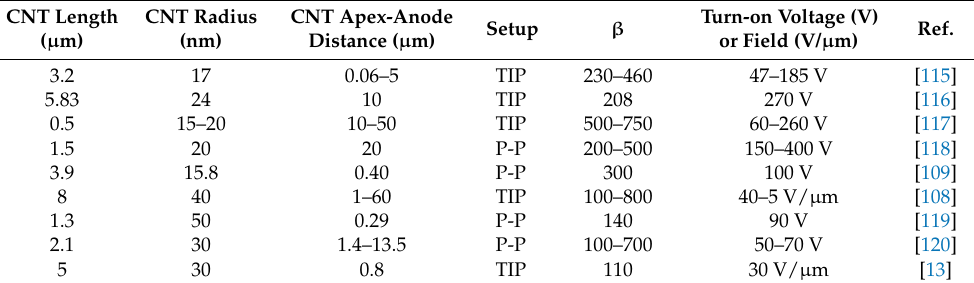
Table 1. Field emission characterization of individual multi-walled CNTs for (CNT apex-anode) distances below 100 µ m. Geometrical parameters of the CNT (length and radius), setup configuration being parallel-plate (P-P) or tip-shaped (TIP), field enhancement factor β and turn-on voltage or field are also